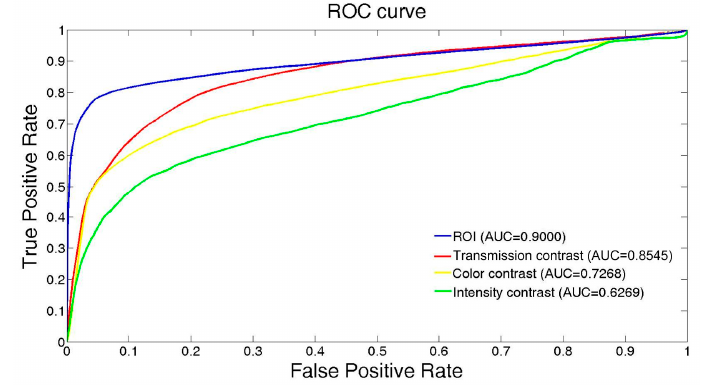
Figure 5. Performance evaluation of the intensity, color, and transmission contrasts, and our ROI detection method. AUC = area under the curve.